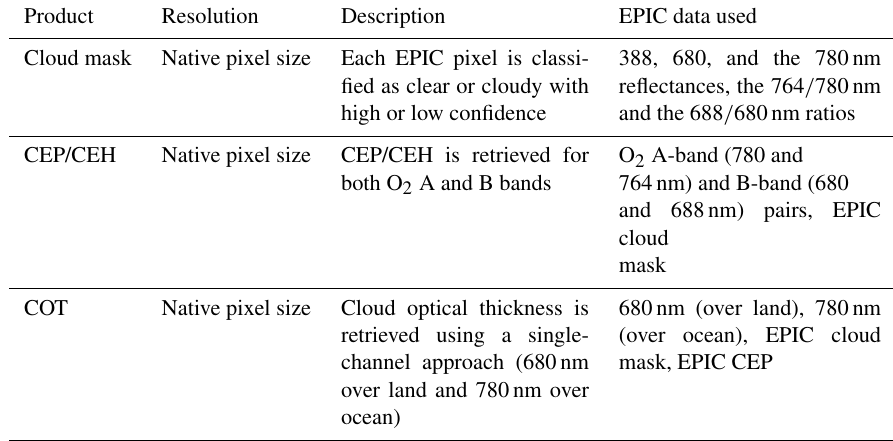
Table 1. List of current EPIC cloud products and required EPIC observations. The native EPIC pixel size is roughly 8km at